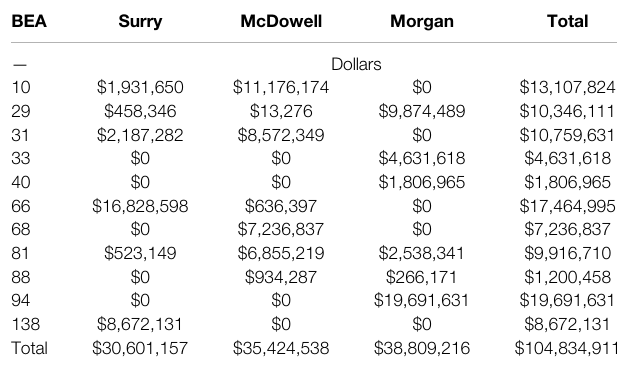
TABLE 6 | Cost of the delivered forest residues supplied by